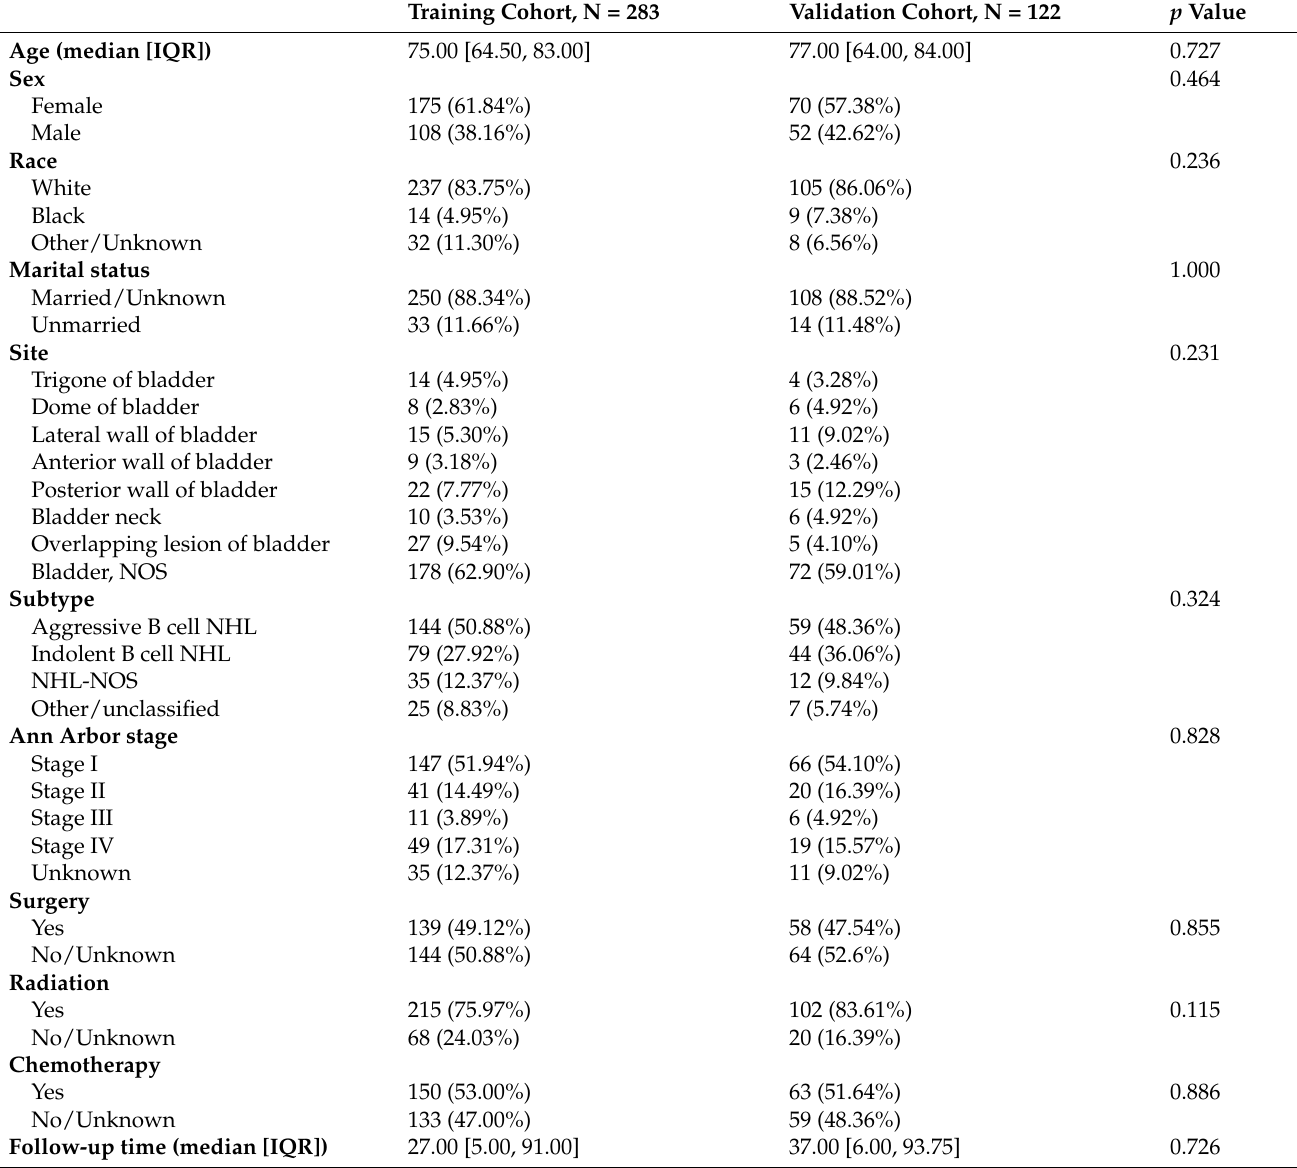
Table 1. Baseline characteristics of original data set patients with primary bladder lymphoma (N =